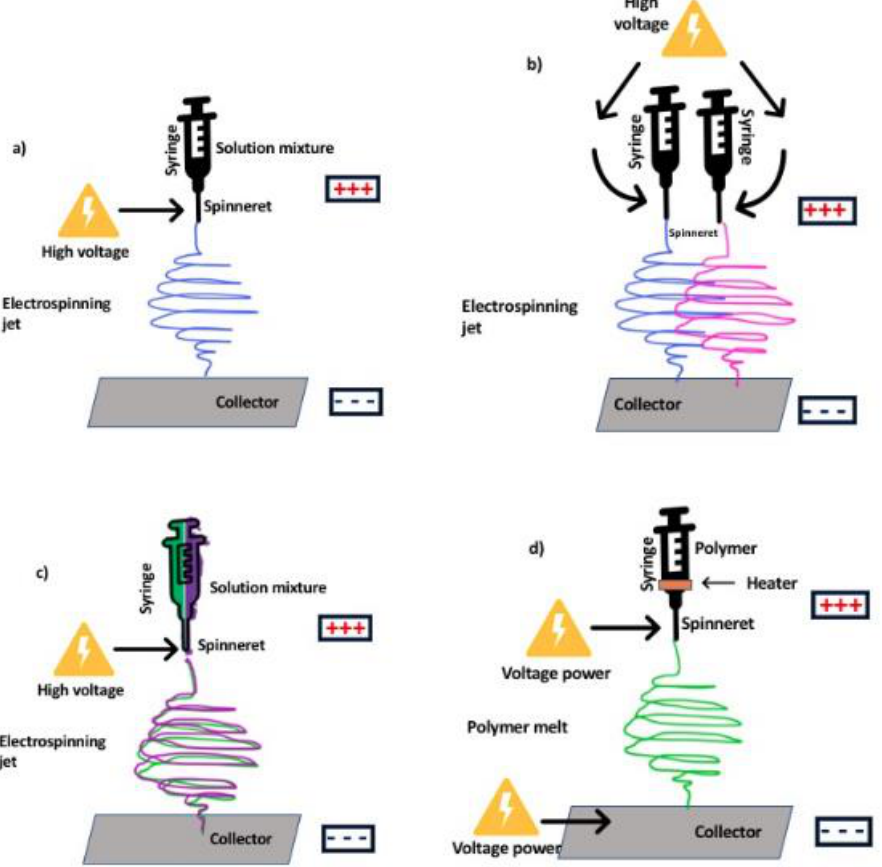
Figure 2. Various kinds of electrospinning setups for nanofiber fabrication: ( a ) conventional one-nozzle solution electrospinning; ( b ) dual or multi-nozzle; ( c ) Side-by-side electrospinning, and; ( d ) melt electrospinning.